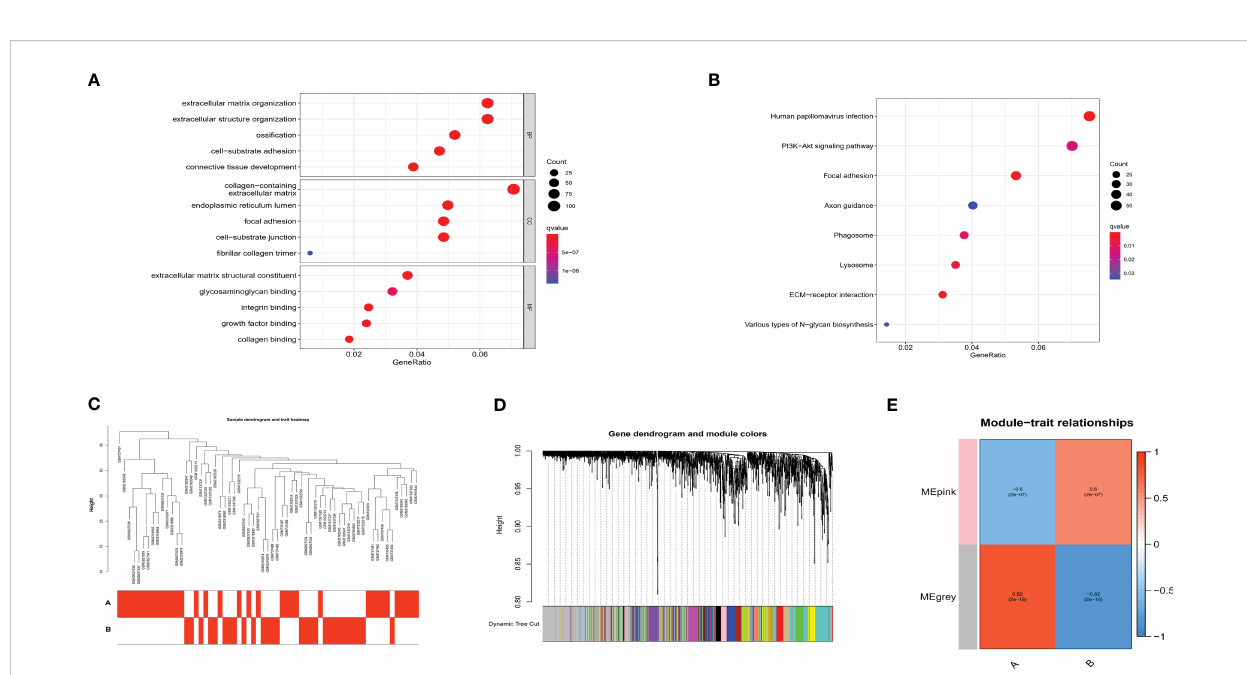
FIGURE 10 Functional analysis of m6A phenotype-related genes in OA. (A) GO enrichment analysis. (B) KEGG enrichment analysis. (C) Sample dendrogram and trait heatmap using WGCNA. (D) Hierarchical clustering tree shows each module. (E) Heatmap shows the relationship of m6A RNA methylation modi fi cation pattern with module